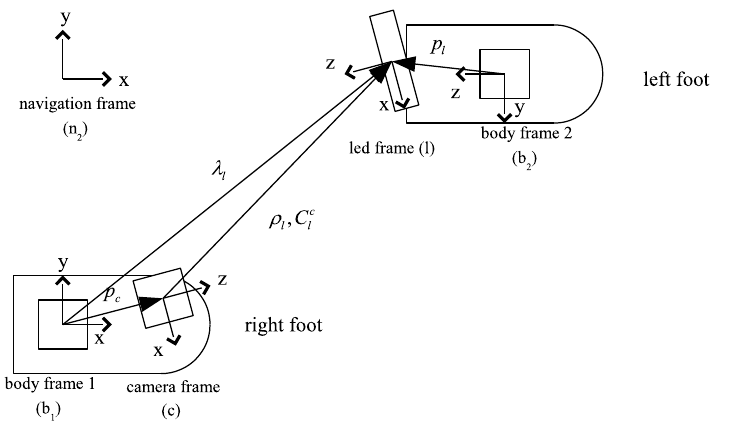
Figure 2. Five coordinate systems (indicated coordinate axes are